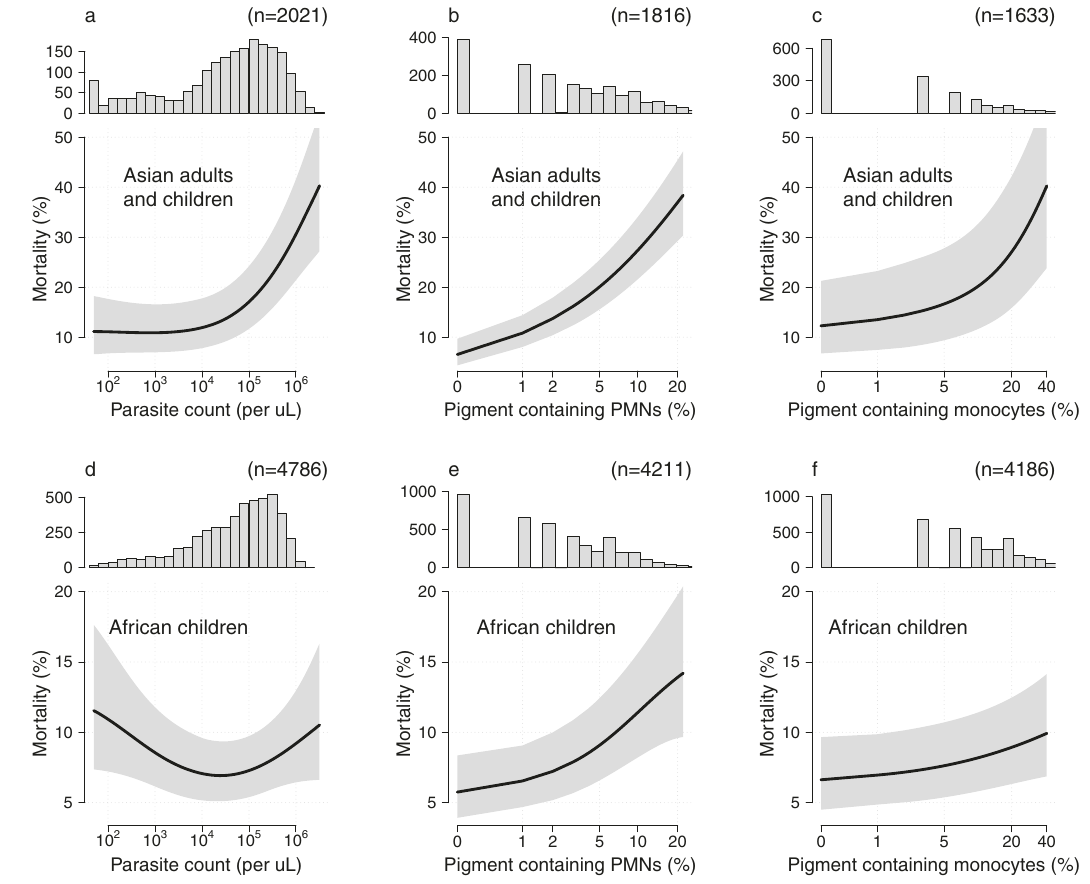
Fig. 1 | New data from three randomised controlled trials in severe falciparum malaria. The prognostic value of quantitative microscopy parasite counts, pig- ment containing neutrophil (PMN) counts and pigment containing monocyte counts. Panels a – c show data from Asian adults and children (AQ Vietnam and SEAQUAMATtrials);panels d – f show datafromAfricanchildren(AQUAMATtrial).